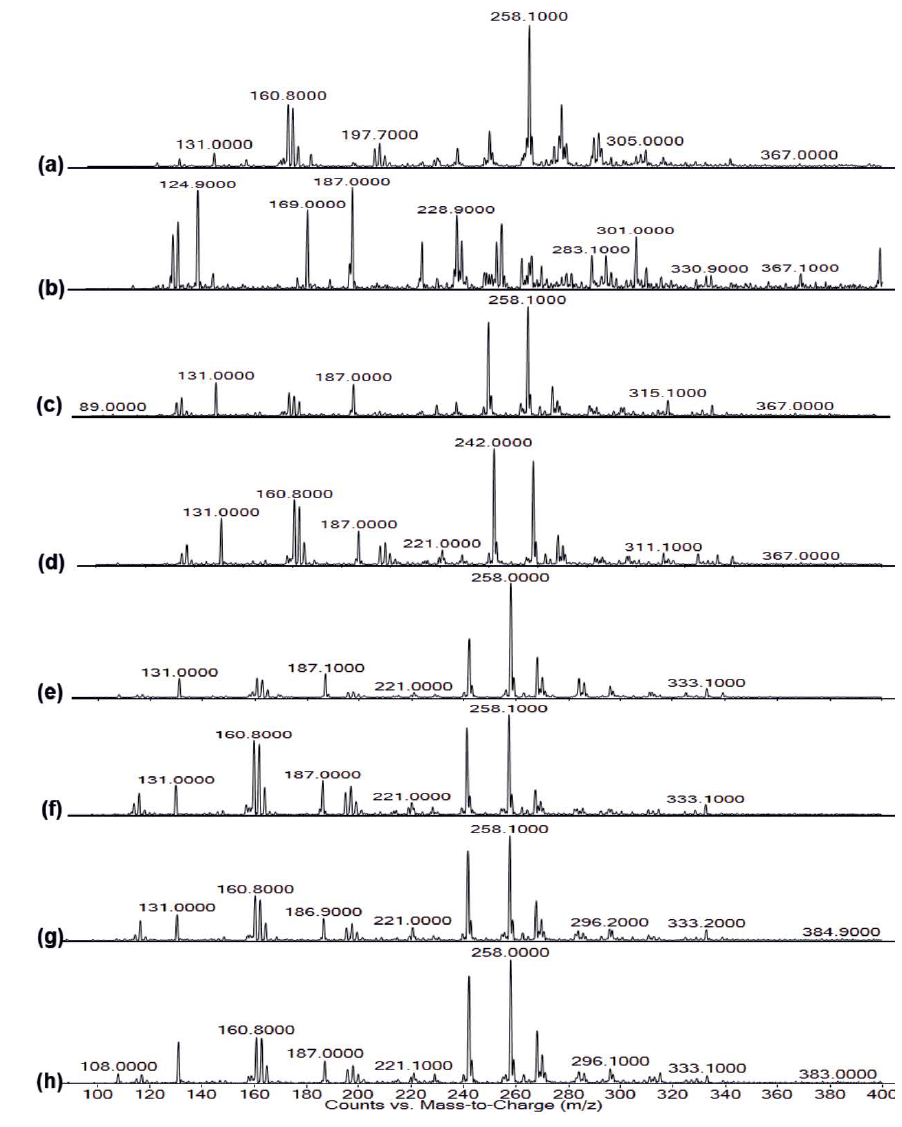
Fig. 7. LC-MS of AHL extracted (a) Control, (b) Punica granatum, (c) Citrus reticulata, (d) Vitis amurensis, (e) Carica papaya, (f) Vitis vinifera, (g) Ananas comosus, (h) Ficus